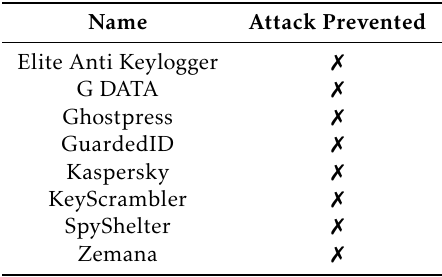
Figure 8. Changed window focus behaviour due to Mouse Underlaying.